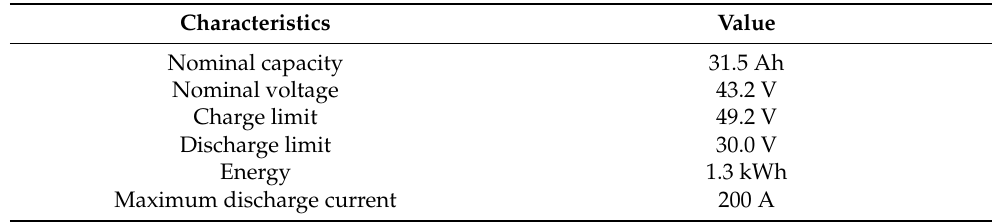
Table A1. Specification of the Li-ion battery cell.